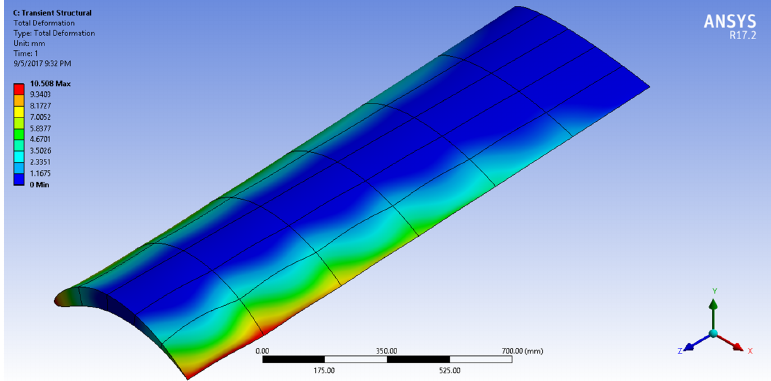
Figure 16. Input (deformation) distribution to morph NACA2410 to NACA8410 along the wing.